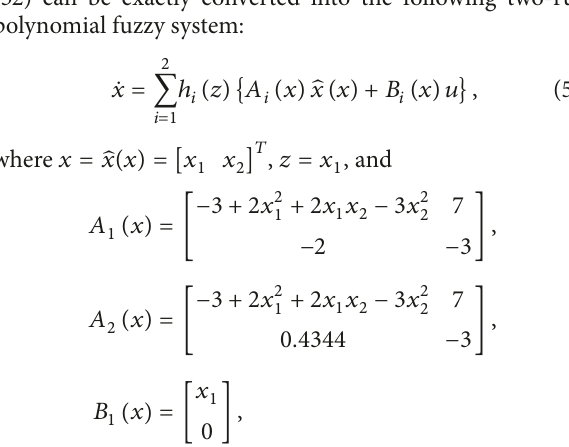
Figure 2: The state responses of polynomial fuzzy system (47) for the initial point 𝑥(0) = [−2 −6]